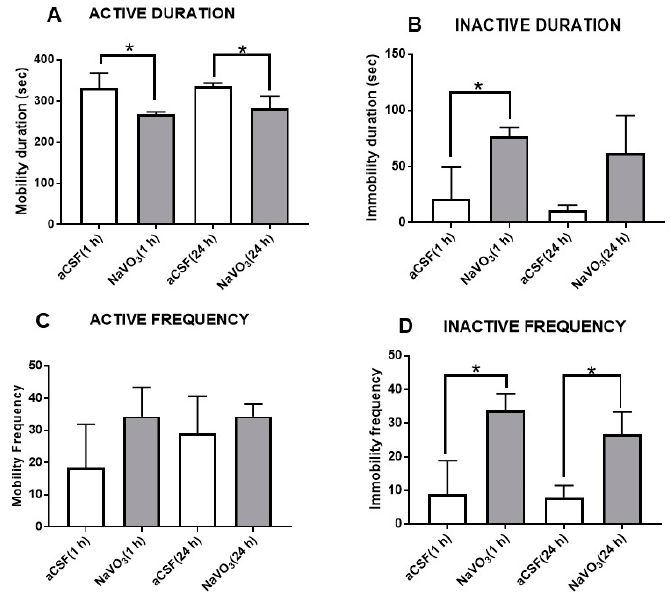
Figure 4. Effect of NaVO 3 on mouse behavior in forced swimming test. NaVO 3 was injected (3 µ L from a 10 mM stock solution in aCSF) into the lateral ventricle. The FST was performed as described in Materials and Methods. Active duration ( A ), inactive duration ( B ), active frequency ( C ), and inactive frequency ( D ) were recorded with EthoVision XT, video tracking software. (number of mice = 6); * significantly different from mice receiving aCSF, p <